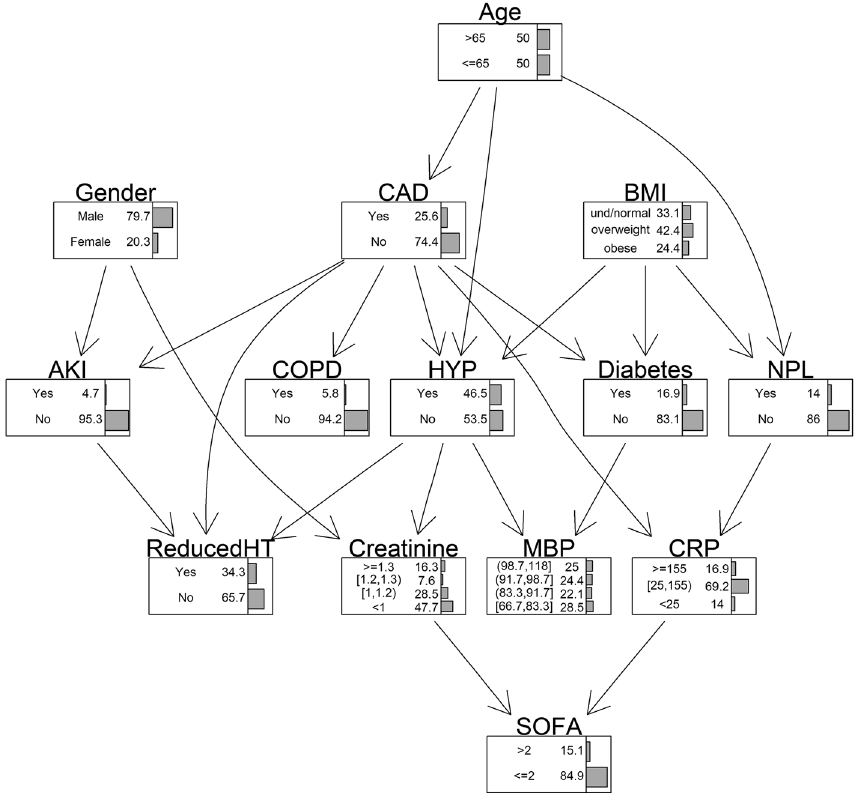
Figure 3. Bayesian Network Model for SOFA with marginal probability tables expressed in percentage. Outcome: SOFA > 2; covariates: age, sex, BMI, CRP, creatinine, CAD, diabetes, COPD, NPL, MBP, AKI, HYP and the reduction of anti-hypertensive therapy after